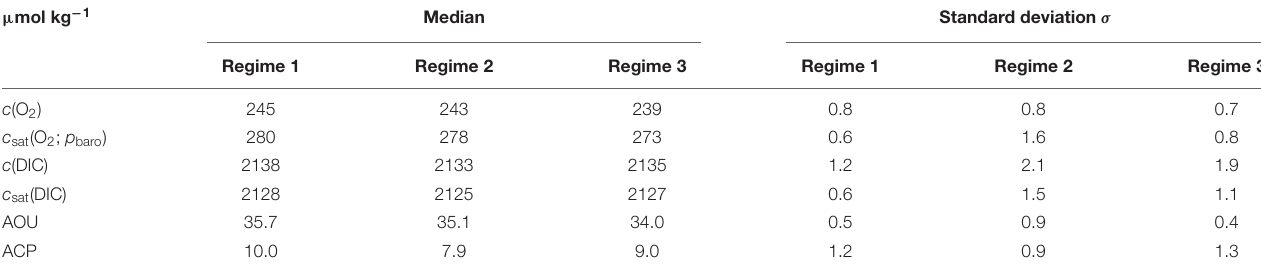
TABLE 3 | Median BML values and standard deviations of AOU, ACP, and related